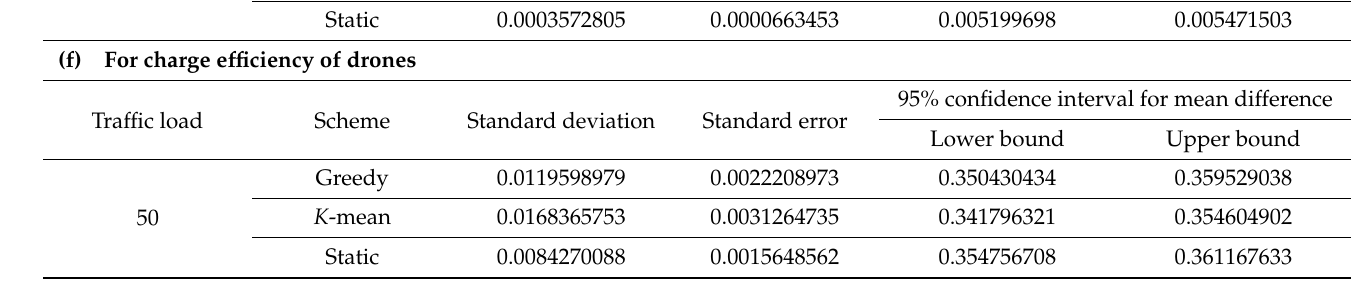
Table 6. LSD post hoc